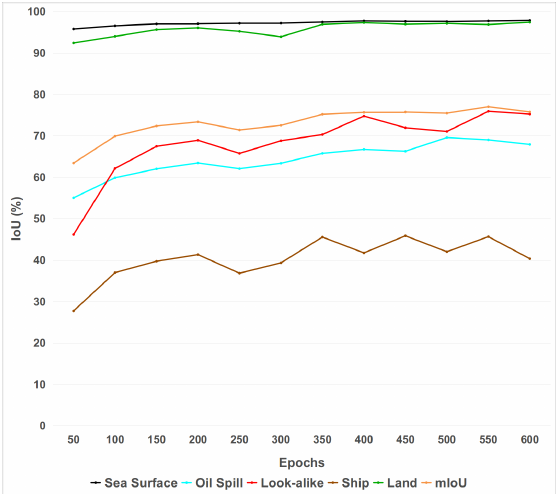
Figure 6. DeepLabv3+: intersection-over-union (IoU) measured on training set for each class in respect to the number of training